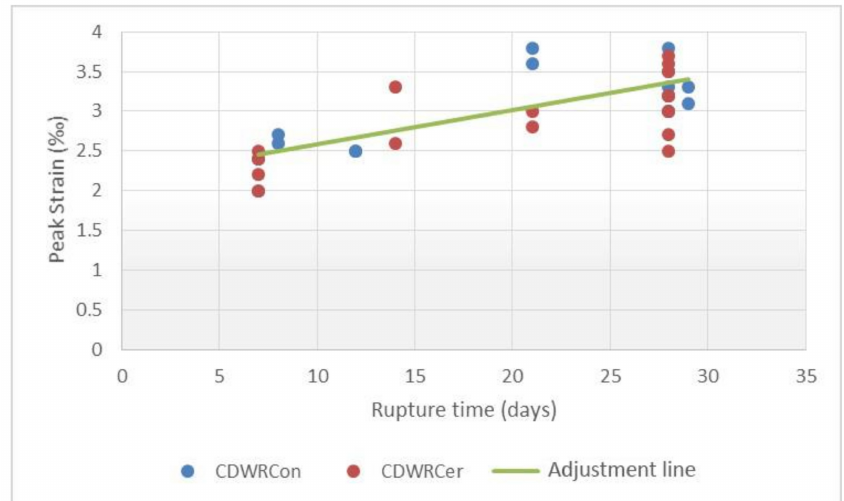
Figure 13. Relationship between rupture time and peak strain.